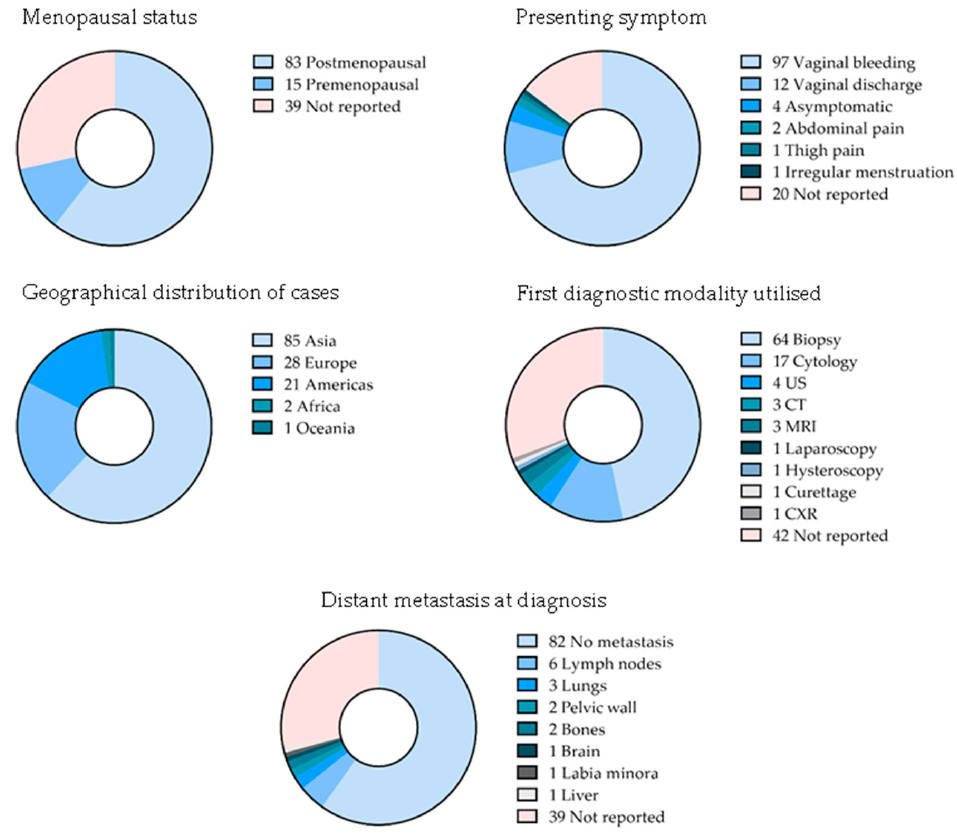
Figure 2. Characteristics of the included